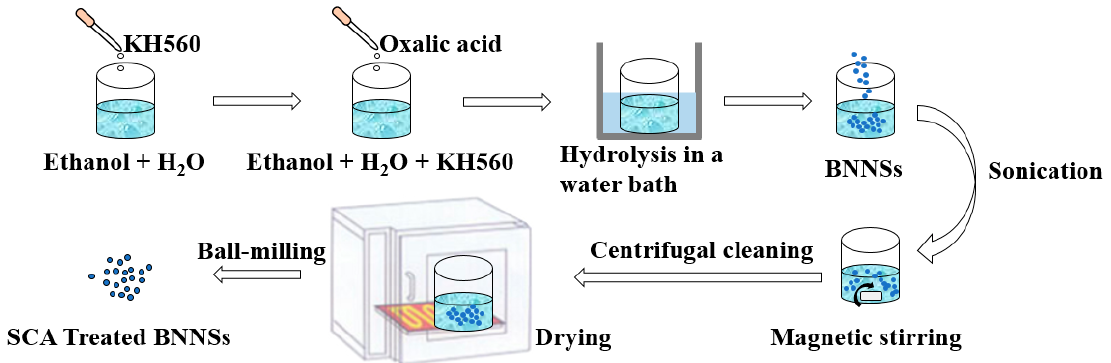
Figure 4. Silane coupling agent (SCA) treatment process.